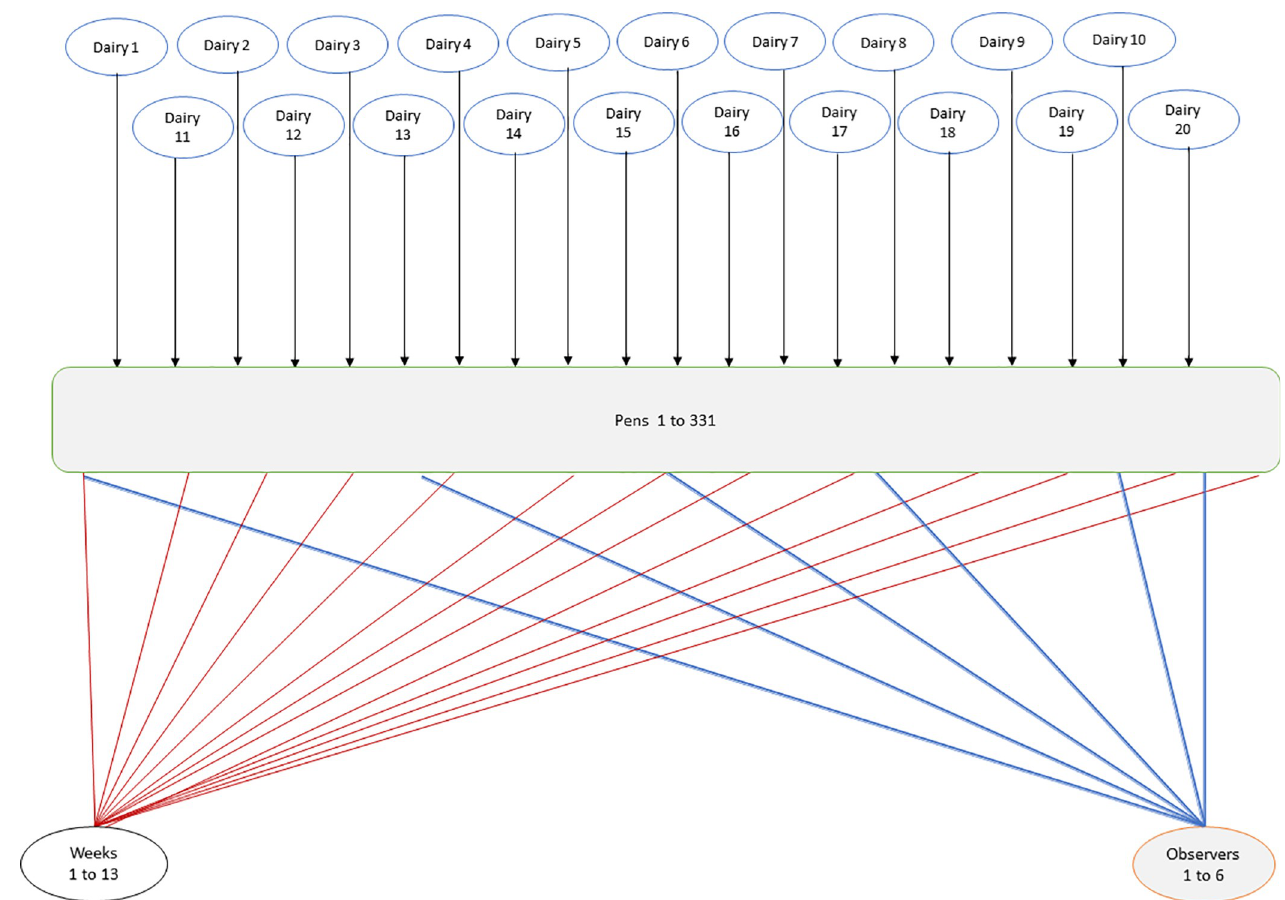
Fig 7. Schematic presentation of a longitudinal study of cow bunching at the pen level using trap fly count/pen. Pens were nested in dairies and crossed by observers and weeks. For example, nesting implies that pen 1 in dairy 1 differs than pen 1 in other dairies. Crossing implies that the weeks of bunching observations, for example, were the same weeks on all the